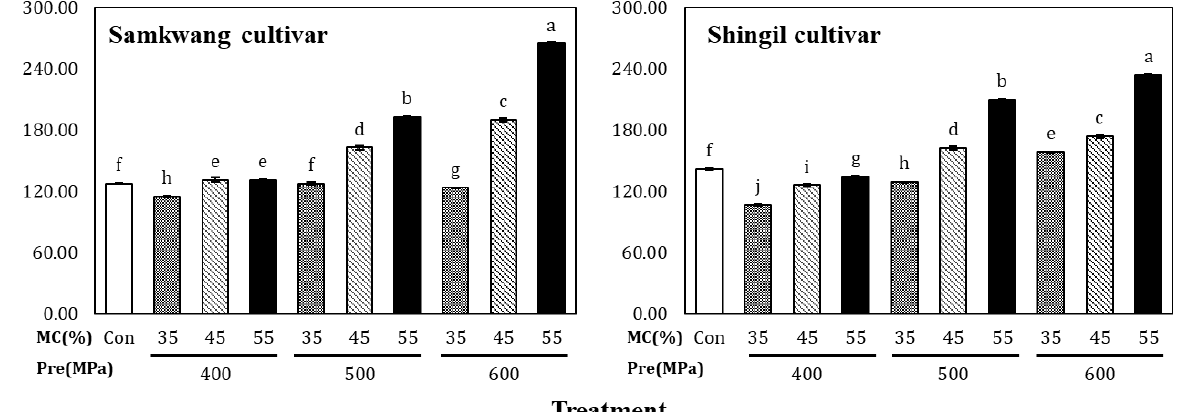
Figure 1. Water absorption capacity of high hydrostatic pressure treated rice flour at different moisture levels. Con: Control, MC: Moisture content of rice flour. Different small letters in the same items indicate a significant result as determined by Duncan’s range test ( p < 0.05), according to the treatment method.